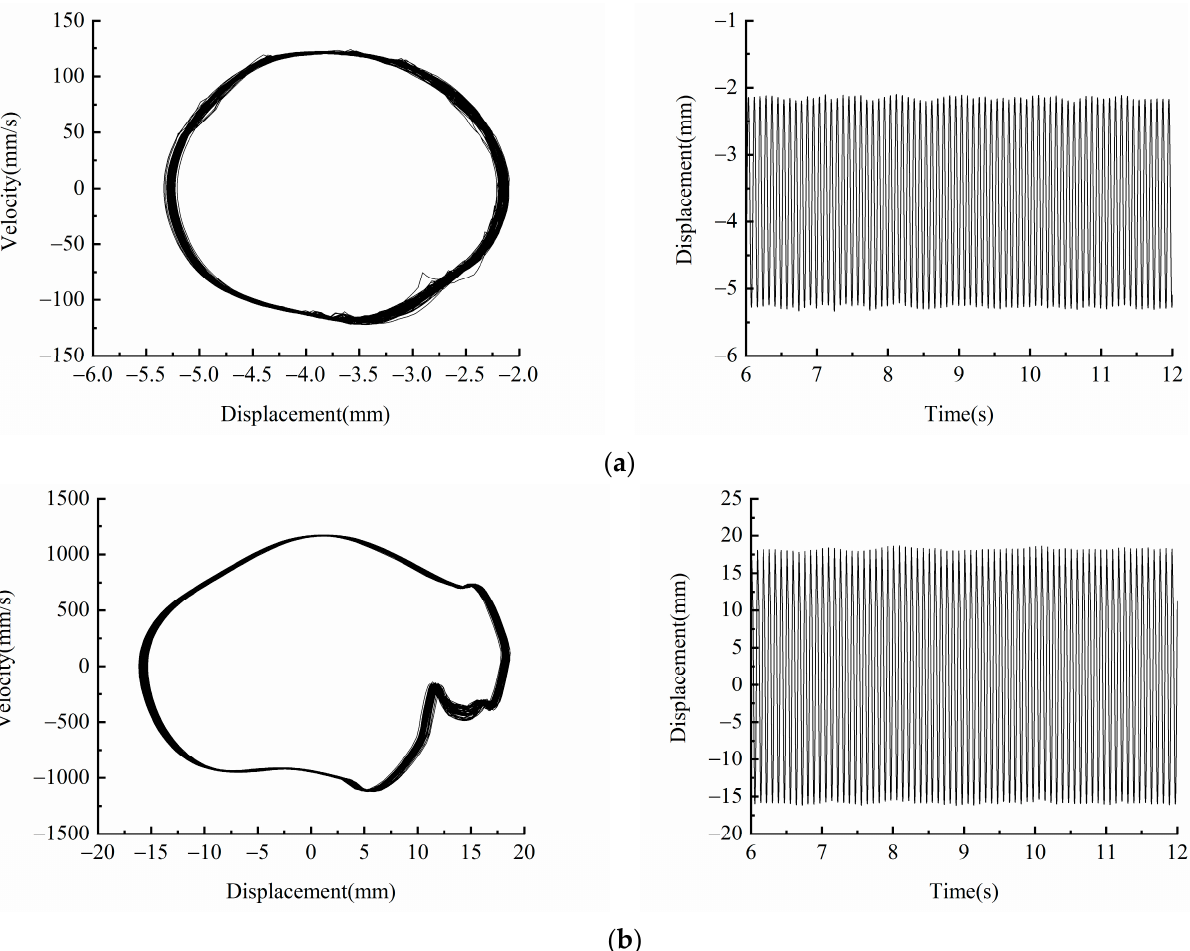
Figure 10. Linear-arch piezoelectric energy harvester.